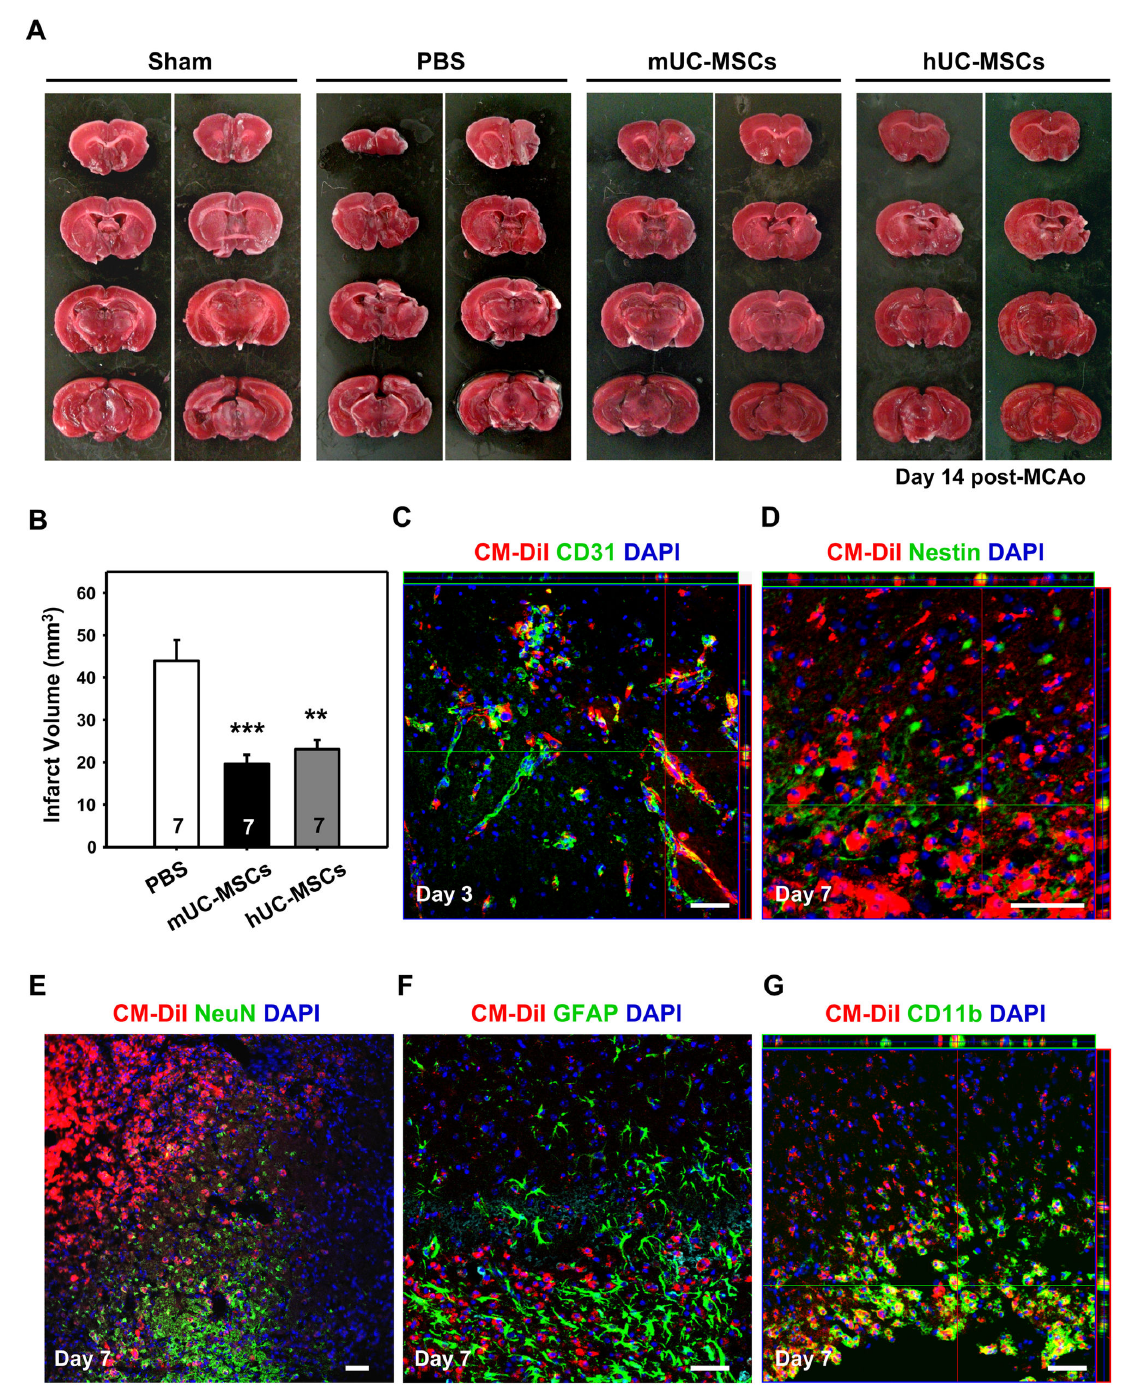
Figure 6. mUC-MSCs transplantation attenuates ischemic brain injury. (A) The C57BL/6JNarl mice were administrated 4 × 10 5 cells of mUC-MSCs, hUC-MSCs, or PBS control at 1 day after a 120-min MCAo. Infarct volume was evaluated 14 days later. (B) Quantification of infarct volume in mice with mUC-MSCs (n = 7), hUC-MSCs (n = 7), or PBS control (n = 7) treatment. For assessment of differentiation potential of mUC-MSCs in vivo , mUC-MSCs were pre-labeled with Cell Tracker CM-DiI fluorescent dye and co-stained with specific cellular markers, including endothelial cell marker, CD31, at day 3 (C); or neural progenitor marker, nestin; neuron marker, NeuN; astroglial marker, GFAP; and macrophage/microglia marker, CD11b at day 7 (D–G) after MCAo. Data shown here are displayed as the mean ± SEM. ** P < 0.01, *** P < 0.001 versus PBS control.